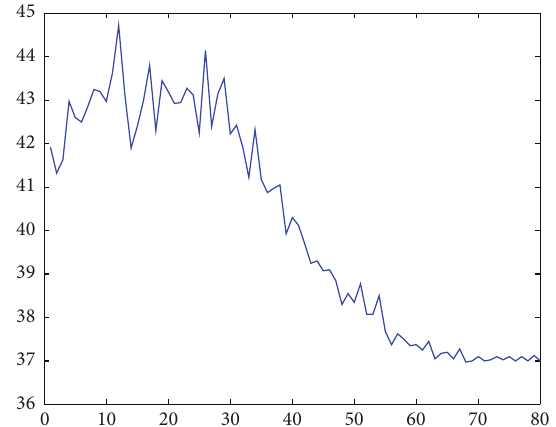
Figure 6: The changing curve of average work time of all individu-